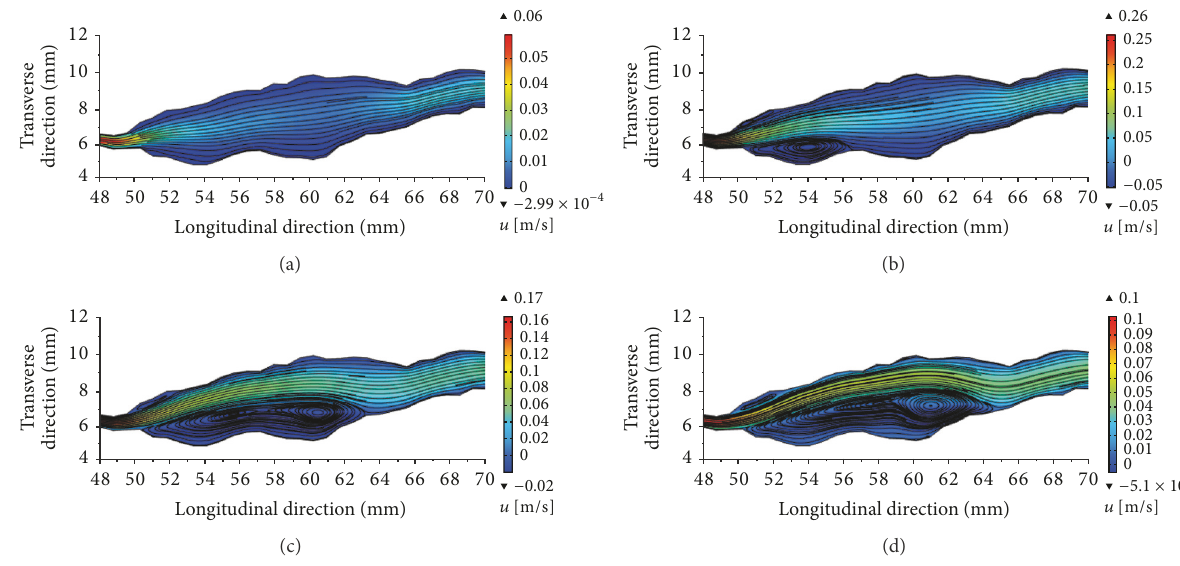
Figure 2: The flow field and eddies formation in the single self-affine fracture with the Re=30, 60, 100, and 170.